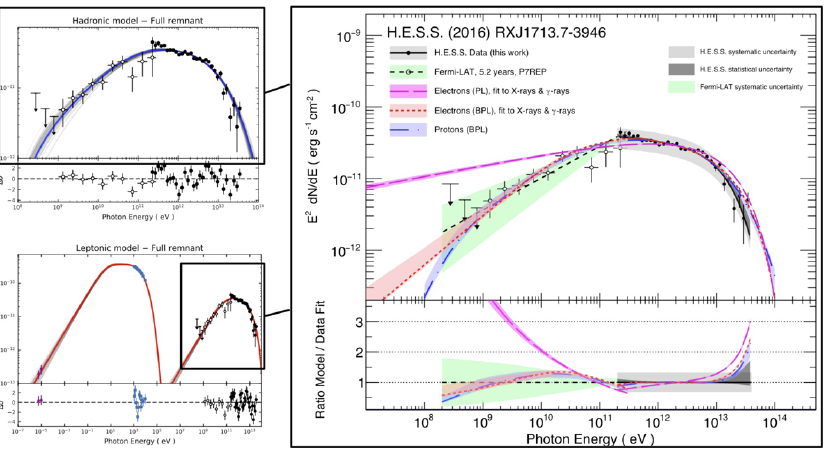
Figure 2. The hadronic gamma-ray model and the leptonic gamma-ray model for the SNR RX J1713.7-3946 compared to data, including lower-energy Susaku X-rays and radio data from ASKA [26] are shown in the top and bottom left panels, respectively (Figure from [18]). The shell broadband spectrum, including data from H.E.S.S. and Fermi-LAT gamma-ray data as solid and open circles, is compared to the best fitting models in the right panel. In addition to the best-fit models of an electron broken power law with a cut-off (BPL), a power law without cut-off is also shown for the leptonic model to demonstrate that this model cannot describe the Fermi-LAT gamma-ray